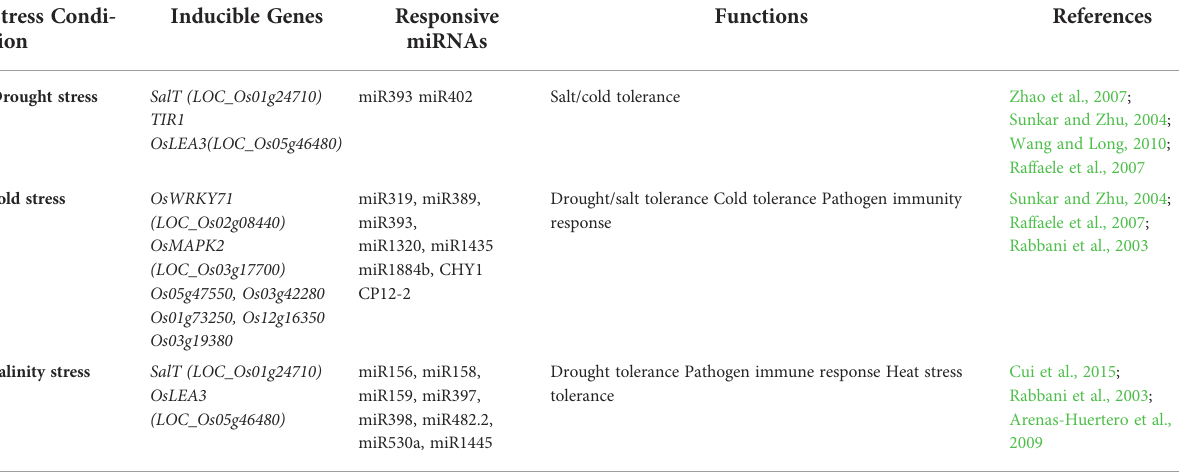
TABLE 3 Examples of miRNAs identi fi ed in Rice (Oryza Sativa) under drought, cold and salinity stress. Stress